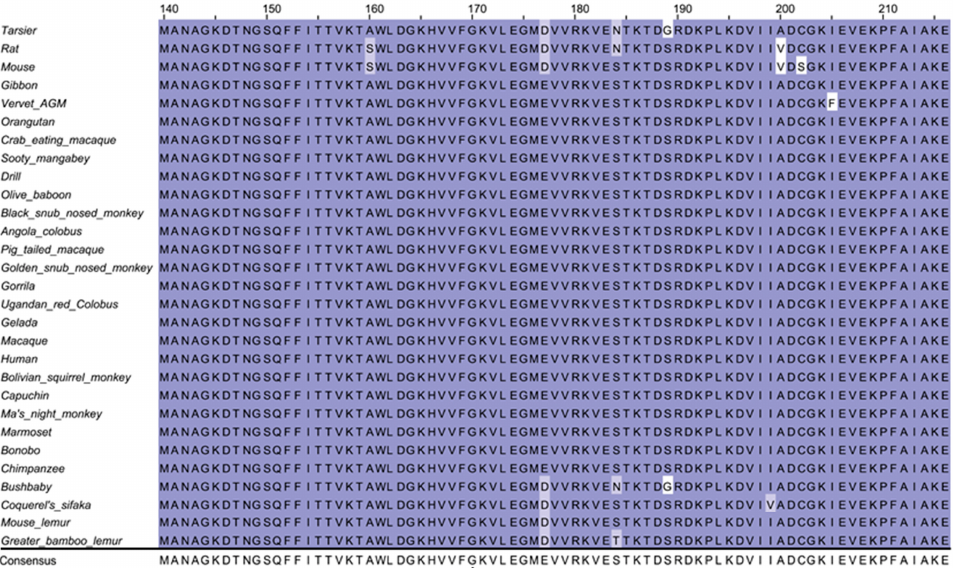
Figure 5. Cross-species conservation analysis of peptidylprolyl isomerase B ( PPIB ) amino acids among human and 28 other mammal species showed a high cross-species conservation of the p.170 glycine residue